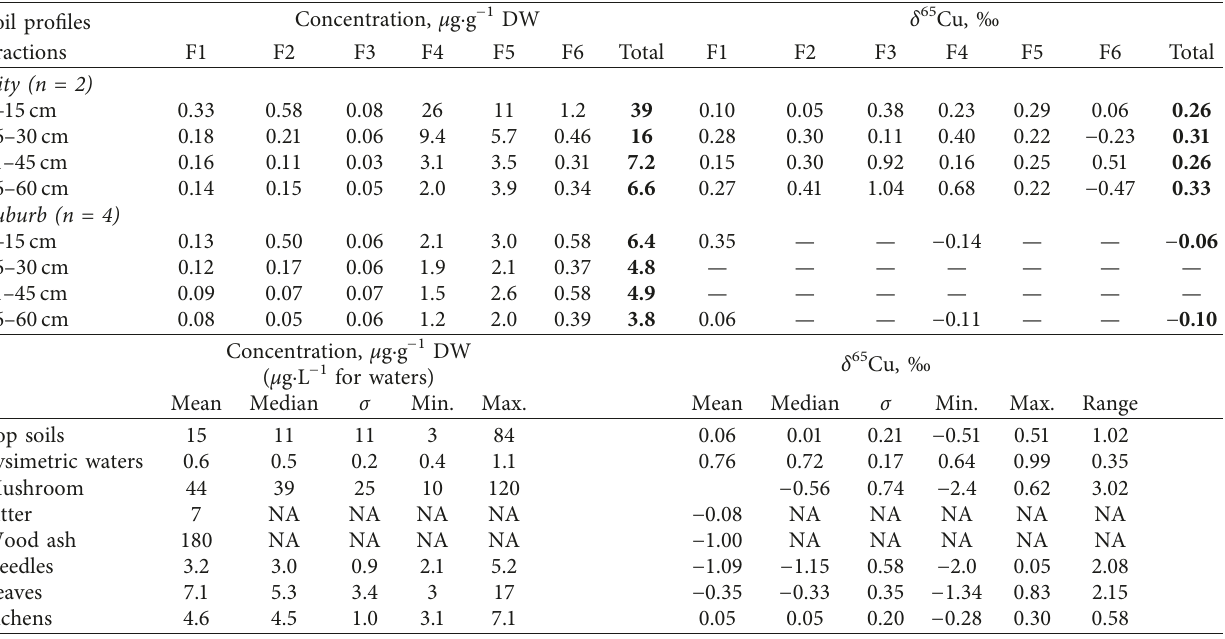
Table 7: Copper concentrations and isotopic composition in environmental samples from